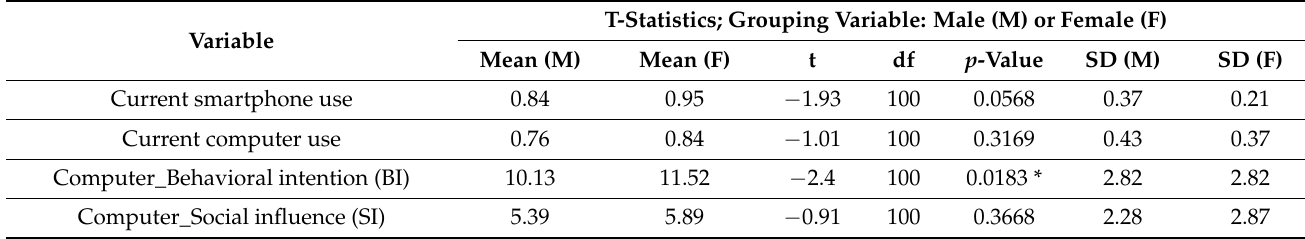
Table 3. Difference between gender groups in current technology use and technology use acceptance